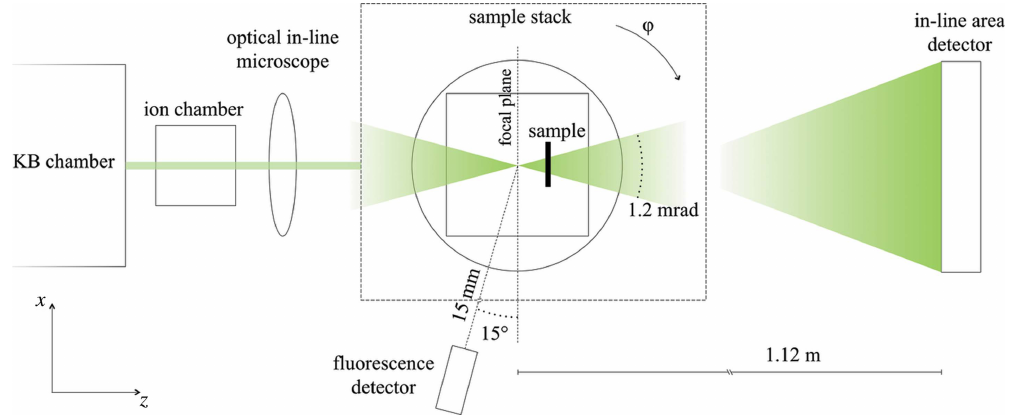
Figure 1 Schematic representation of the multimodal X-ray microscopy experimental setup. KB mirrors focus X-rays down to a focal spot of about 70 nm and with a 1.2 mrad divergence. The sample is mounted on a motor stack enabling xyz translation and (cid:2) , ’ rotation, i.e. around the x and y axes, respectively. The sample can be translated in and out of the X-ray beam focus via translation along z (total travel range 46 mm), effectively tuning the X-ray beam size. An ion chamber is positioned downstream of the KB chamber to monitor the incoming X-ray photon flux. An optical in-line microscope provides a view onto the sample along the optical z axis. A fluorescence detector is positioned 15 mm away from focus, with a 15 (cid:4) orientation with respect to the focal plane. An in-line area detector is positioned 1.12 m downstream of the focus to collect